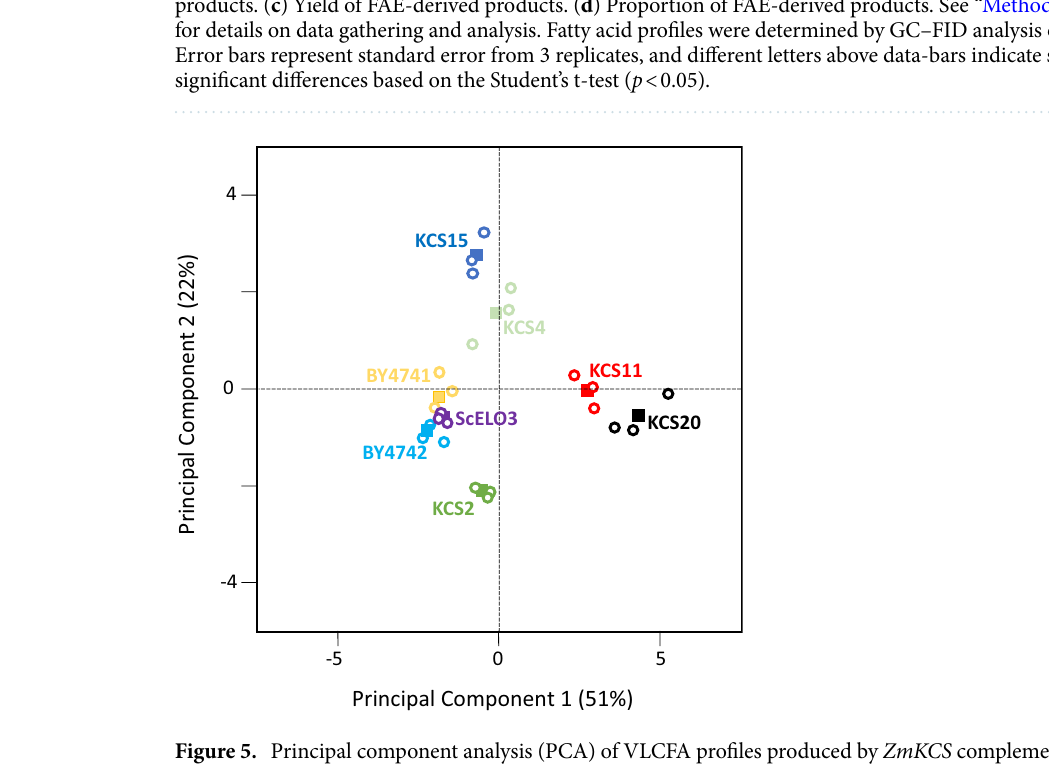
Figure 5. Principal component analysis (PCA) of VLCFA profiles produced by ZmKCS complementing strains. These analyses are of data presented in Fig. 4c,d. Open circle data-points are from each of 3 replicate analyses of each genotype, and the average position of these data-points are displayed as the filled